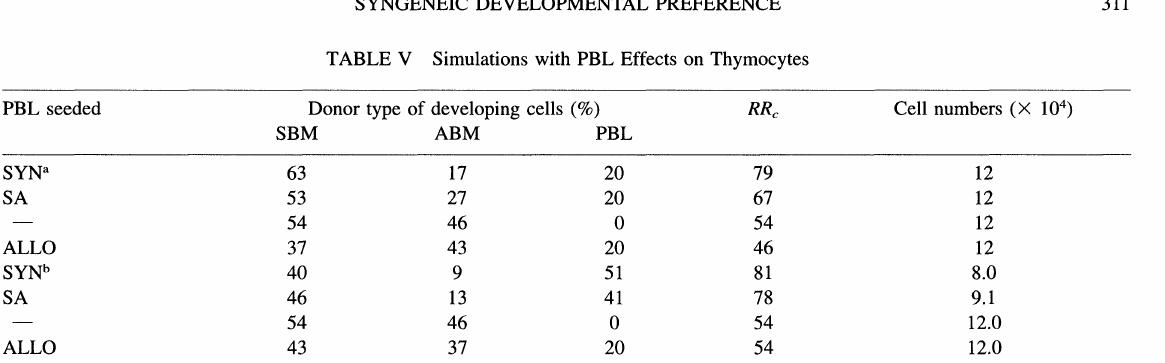
TABLE V Simulations with PBL Effects on